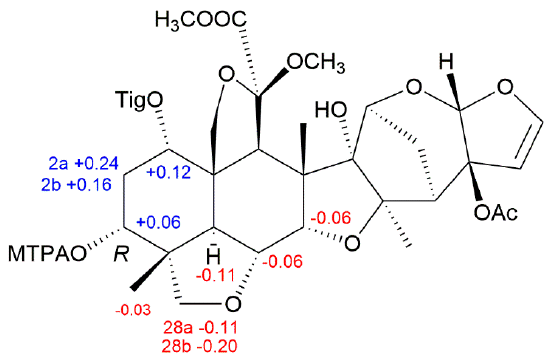
Figure 3. Determination of absolute configuration of limonoid 1 by modified Mosher’s method.